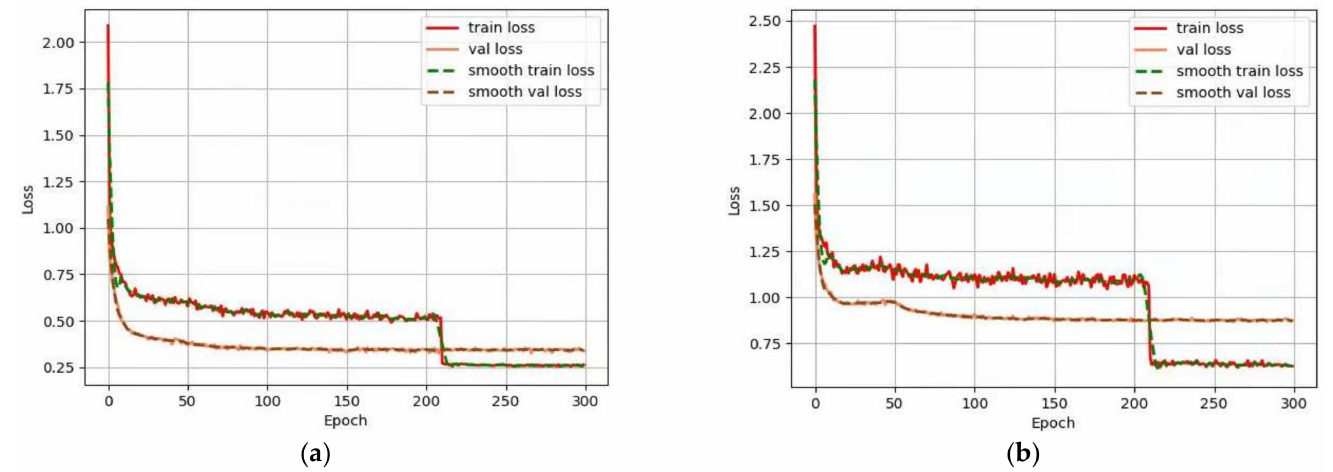
Figure 10. Calculation result of YOLOv5s loss. ( a ) Calculation result of YOLOv5s loss in Scene 1: after weeding; ( b ) calculation result of YOLOv5s loss in Scene 2: before